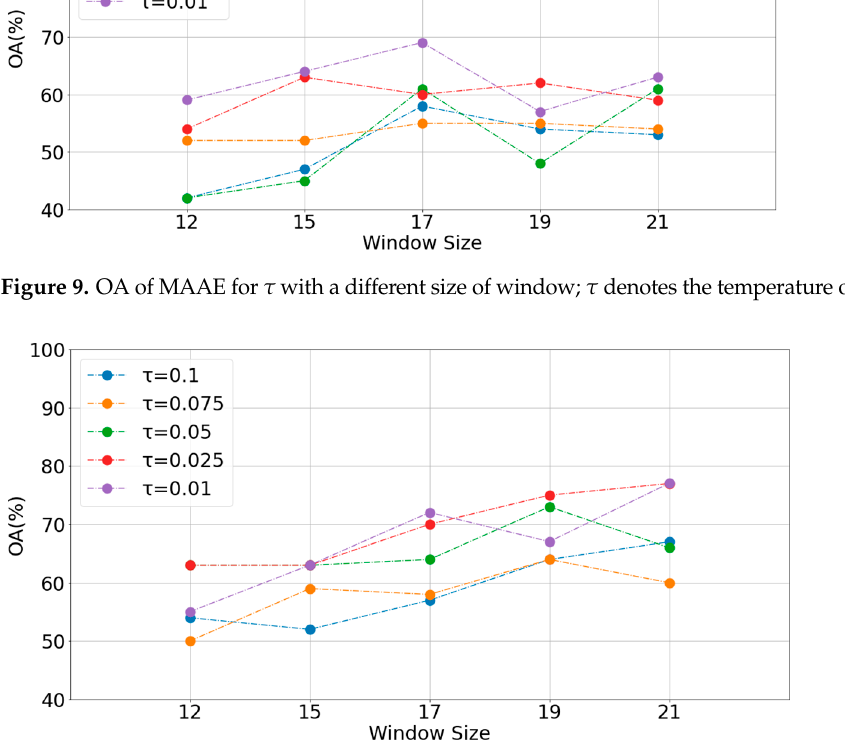
Figure 10. OA of MVAE for τ with different window sizes.